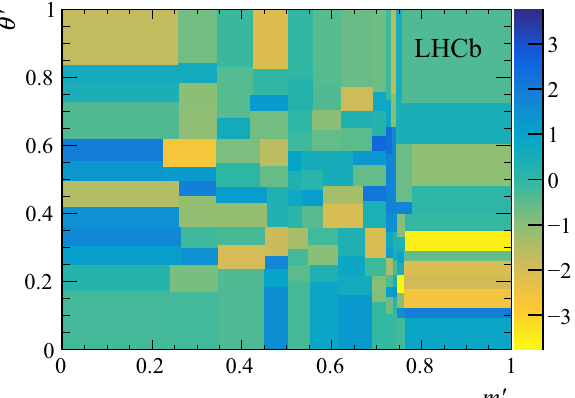
Fig. 13 2D pull distribution for to the baseline model